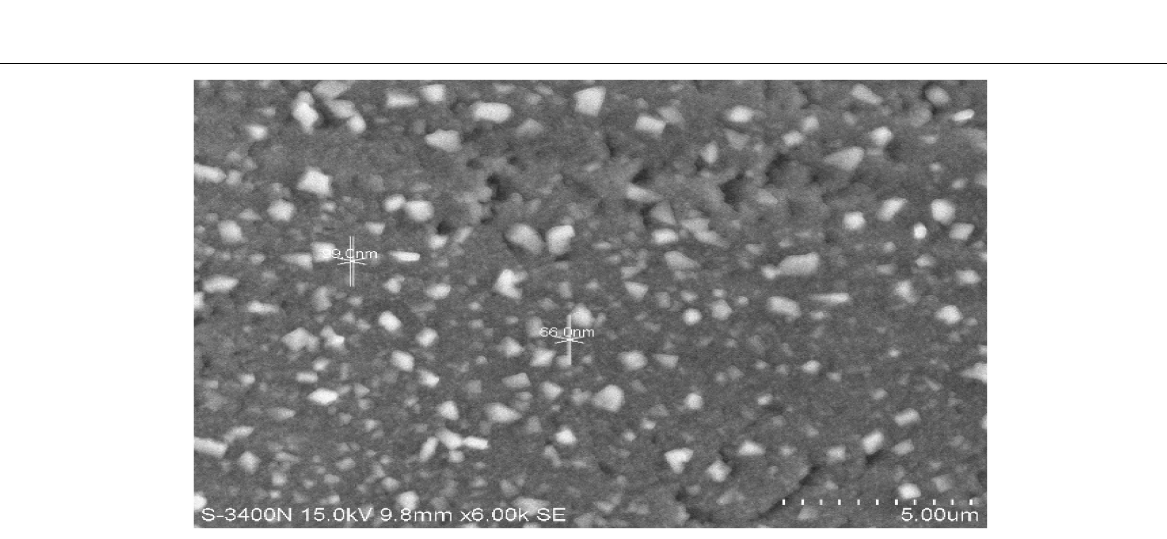
FIGURE 6 | Antimicrobial activity of AgNP of P. variotii combined with methanol extract.